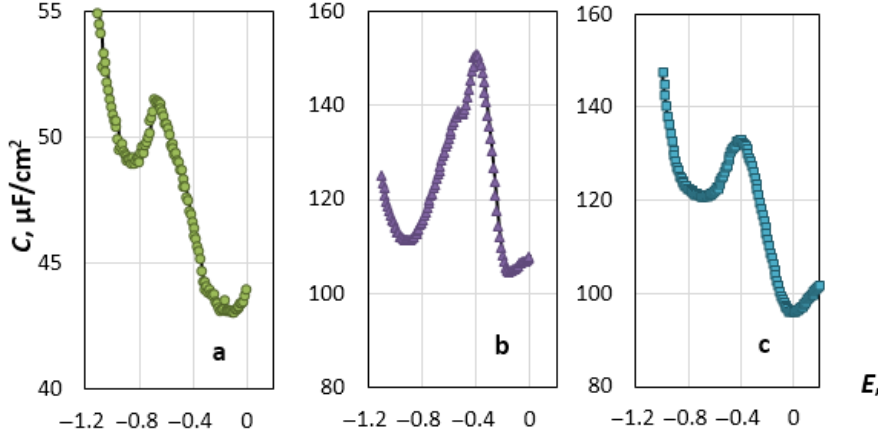
Figure 3. Differential capacitance, C , as a function of the potential, E , for the Re electrode in ( a ) NaCl, ( b ) KCl and ( c ) CsCl melts at 1093 K.